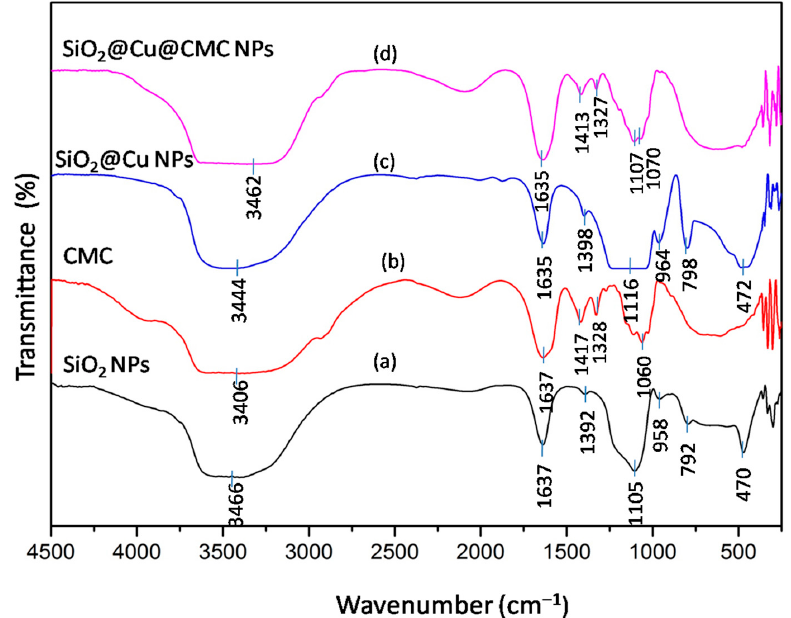
Figure 5. Infrared spectra of ( a ) SiO 2 NPs, ( b ) CMC, ( c ) SiO 2 @Cu NPs and ( d ) SiO 2 @Cu@CMC NPs.